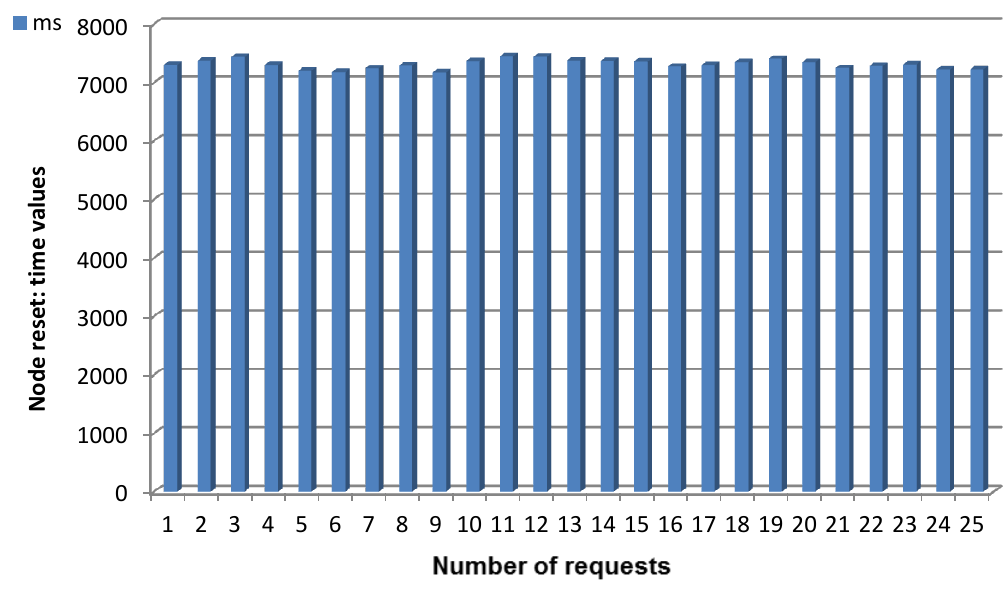
Figure 26. Time used in completing a node reset (25 attempts).